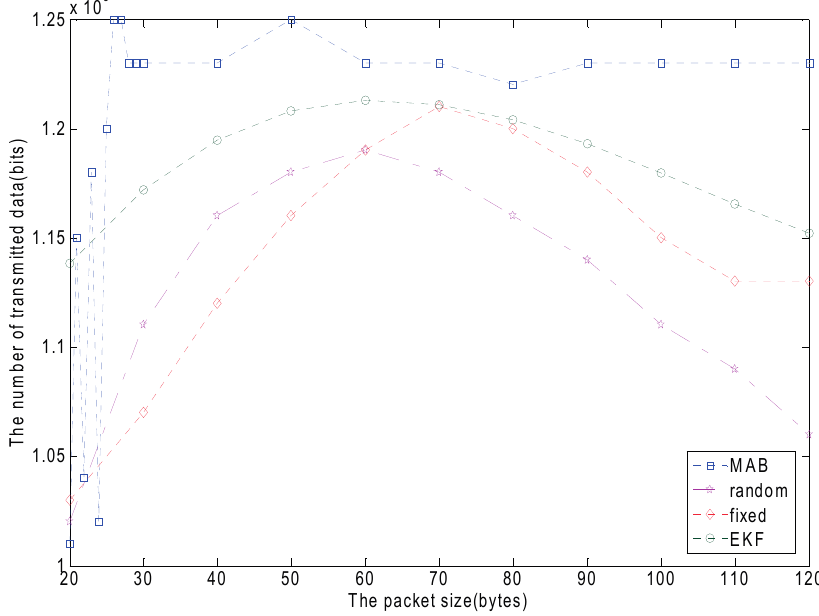
Figure 17. The comparison of the number of successfully transmitted data among different packet-sizing schemes as the packet size